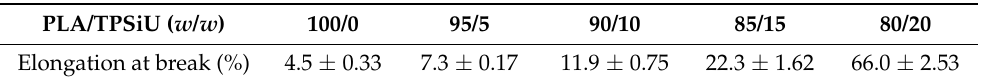
Figure 9. Stress–strain curves of PLA/TPSiU blends. Table 3. Elongation at break for PLA/TPSiU